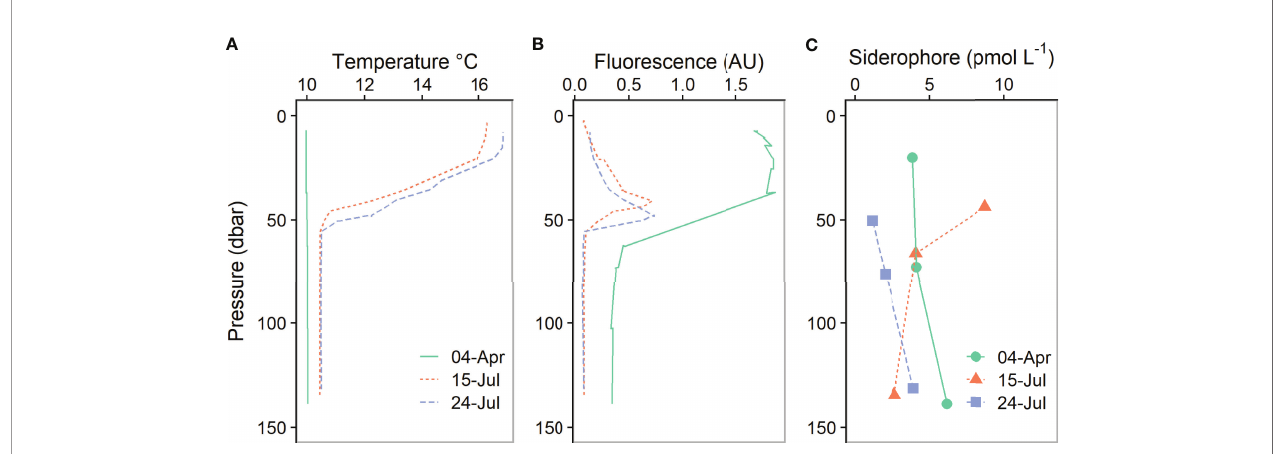
FIGURE 4 | Depth pro fi les showing (A) temperature, (B) fl uorescence and (C) total siderophore concentrations observed in spring (April 2015) and summer (July 2015).